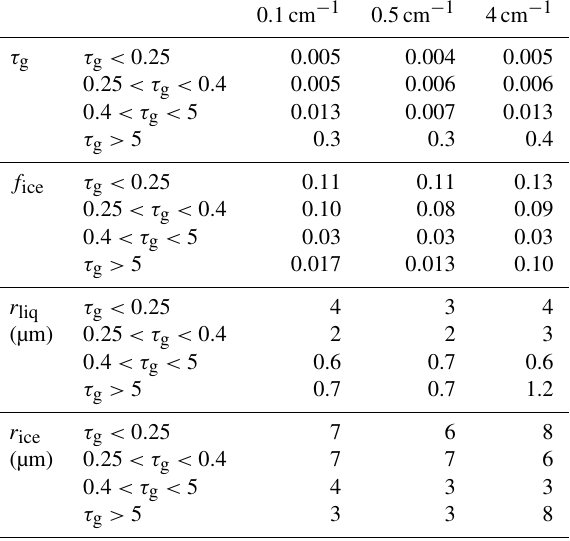
Table 3. Root-mean-square errors in retrieved cloud properties for base set of spectra due to model error only (no errors imposed) for spectral resolutions indicated. Errors are shown for cloud geometric optical depth ( τ g ), ice fraction ( f ice ), effective radius of liquid ( r liq ), and effective radius of ice ( r ice ) for four ranges in τ g